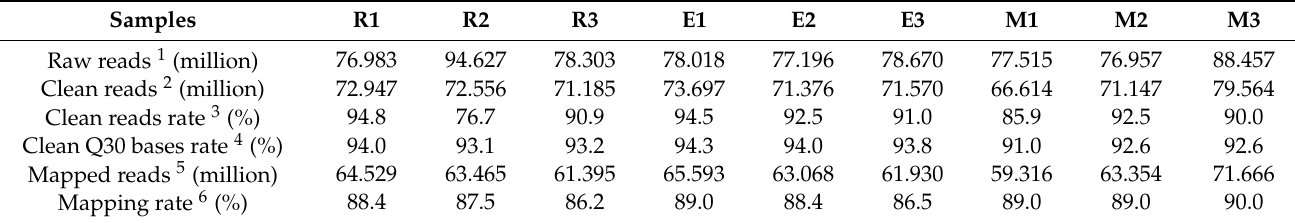
Table 1. Sequencing output of bovine spermatid and sperm